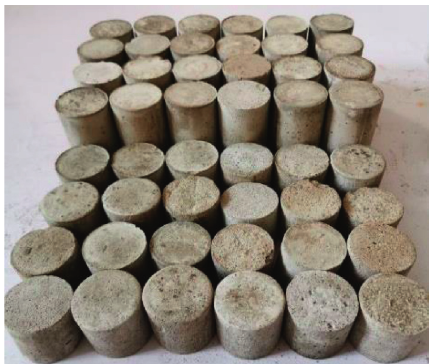
Figure 4: Partial standard specimen covered by the study.